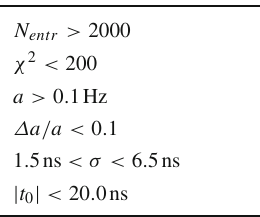
Table 1 Values of data selection criteria applied in the analysis. The parameter nomenclature corresponds to the one used in Eq.